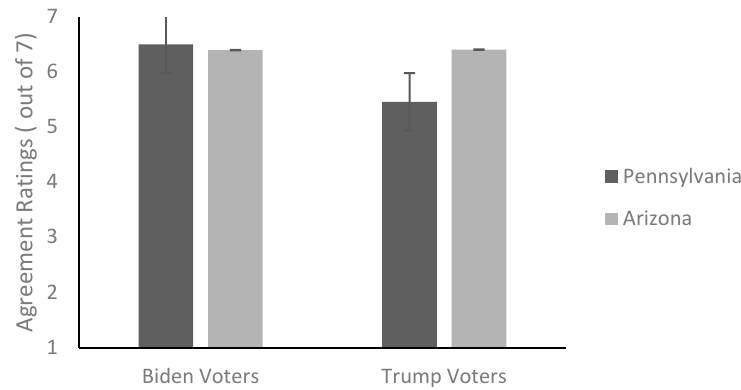
Figure 5. Support for counting all votes in the 2020 election with target states.